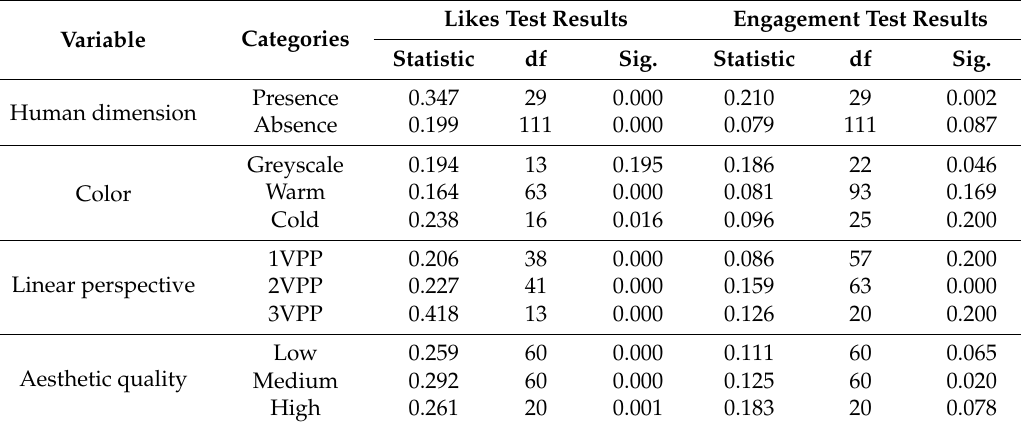
Table 1. Kolmogorov–Smirnov test results (dependent variables: likes and engagement).